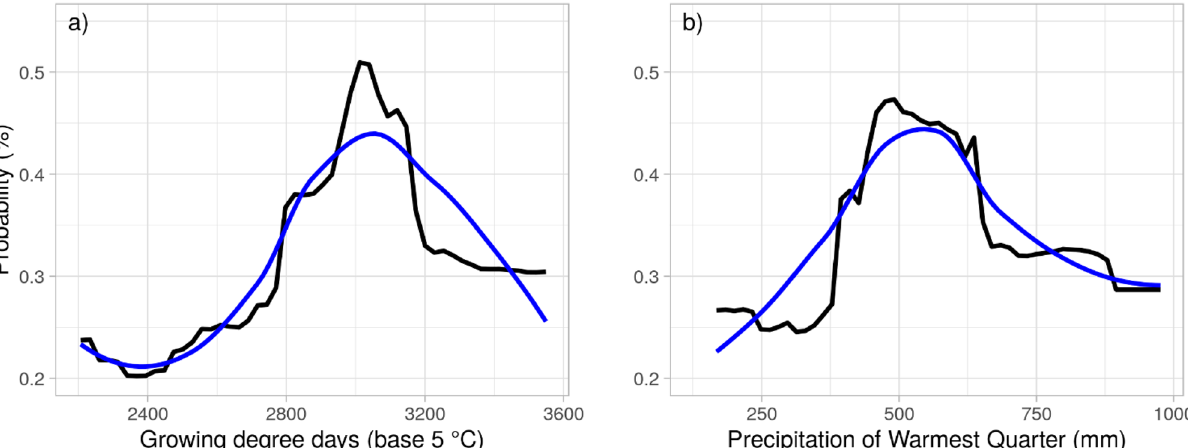
Figure 4. Partial dependence plot for the two variables that most explain overwintering survival in the prediction analysis at the apiary level. Plot ( a ) describes the relationship between the growing degree days (along the x axis) and the probability of overwintering survival (y axis), given all the other variables in the model. Plot ( b ) describes the relationship between the precipitation during the warmest quarter (along the x axis) and the probability of overwintering survival (y axis), given all the other variables in the model. In both the plots, the black line represents the modeled relationship between survival and the variables, while the blue line shows a spline-smoothed